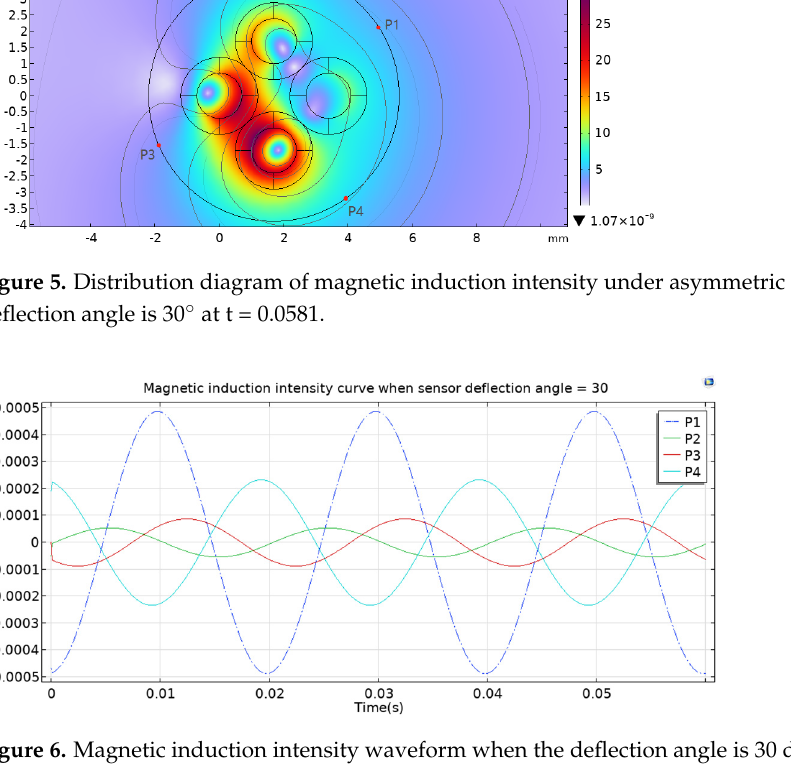
Figure 7. Reduction current curve. Therefore, the amplitude and phase angle of a three-phase four-wire phase current can be reconstructed from the following Formula (16): 2 2 arctan( ) I a b a b ϕ 